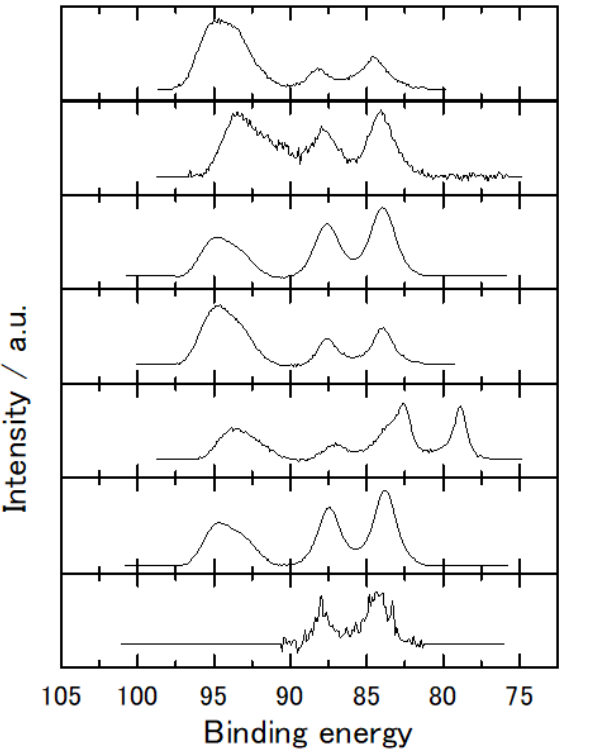
Figure 1. XPS spectra in the Au (4f) region for all tested samples. (* The measurement was limited to the 82–91 eV region; because of low count, it would have taken too long time to measure the extended region).